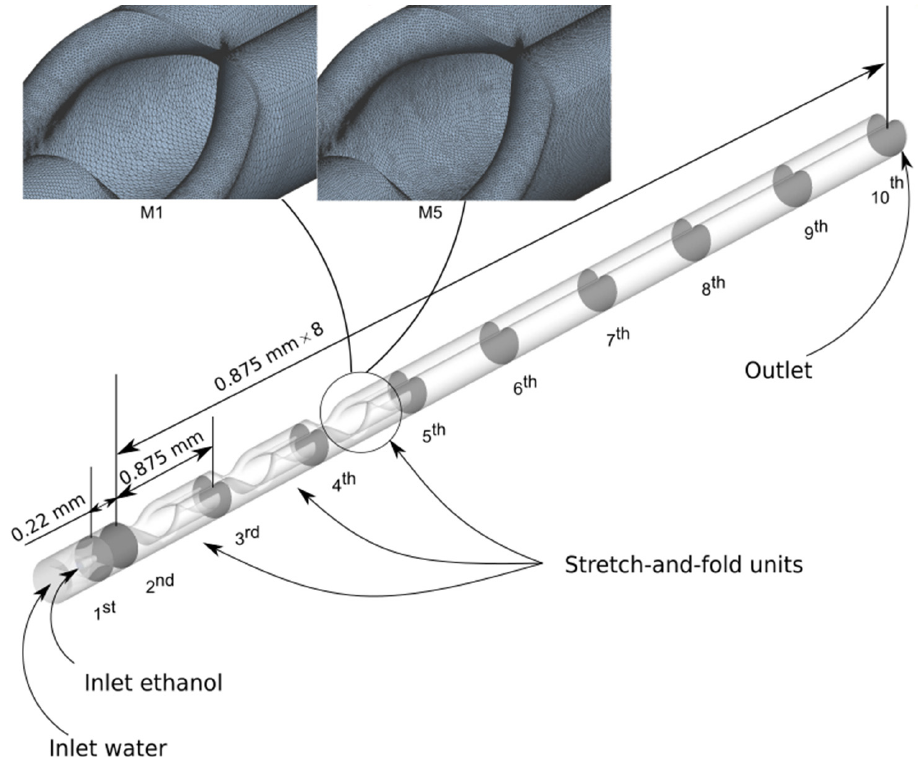
Figure 2. Illustration of the positioning of ten cross-sectional planes in which MI values were obtained. From the second plane onwards, the positioning is equidistant. Zoomed views of a coarser (M1) and a finer mesh (M5) at astretch and fold unit are shown.